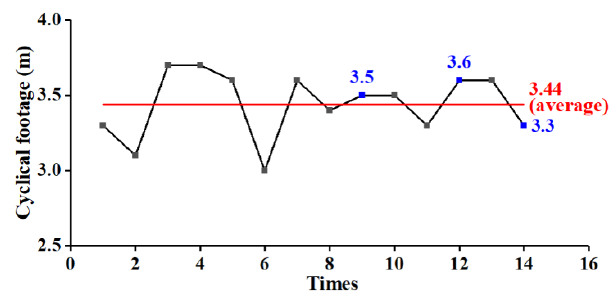
Figure 9. Tunnel excavation cyclical footage.